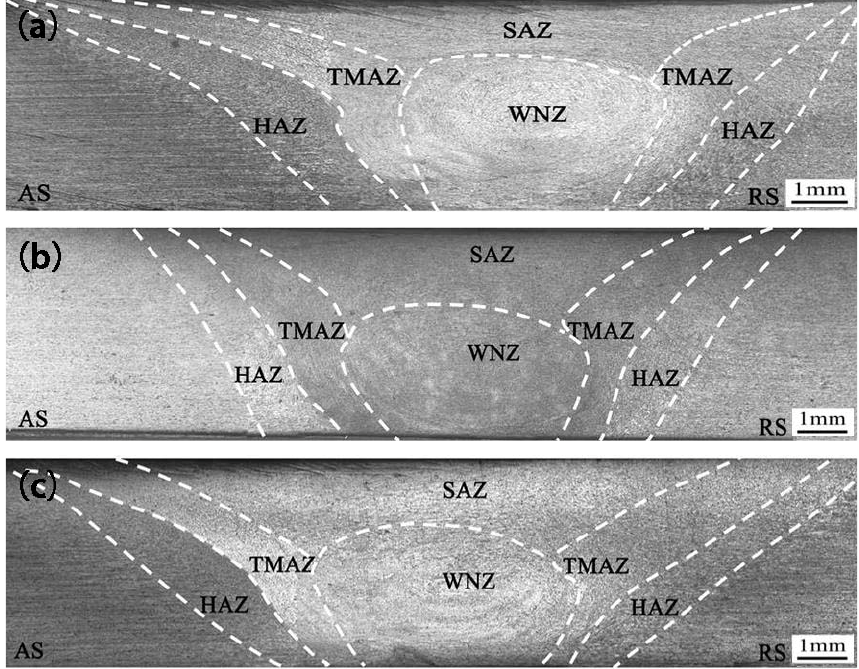
Figure 7. Cross-sectional images of weld zone fabricated with different tool pin profiles. ( a ) tool pin A; ( b ) tool pin B; ( c ) tool pin C.